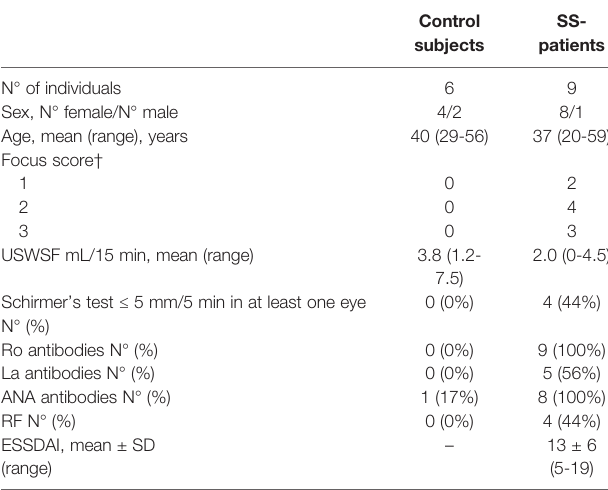
TABLE 1 | Demographic and serological characteristics of SS-patients and control subjects.